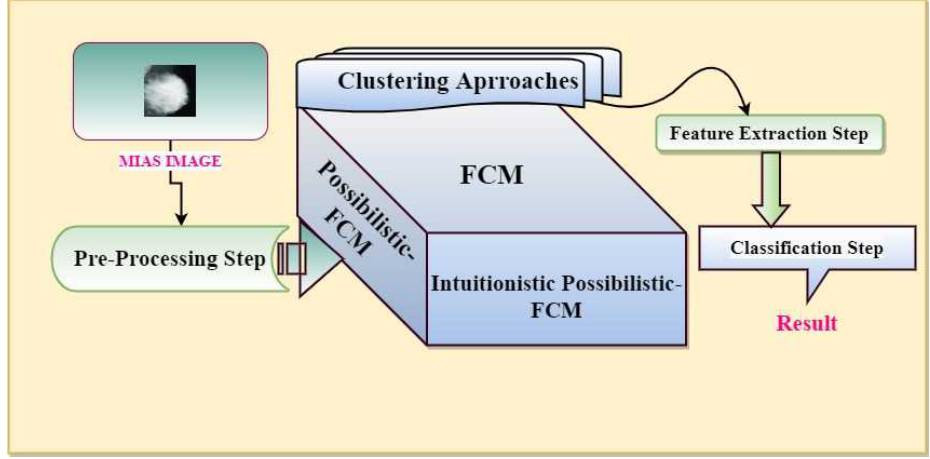
Figure 3. Schematic of the proposed